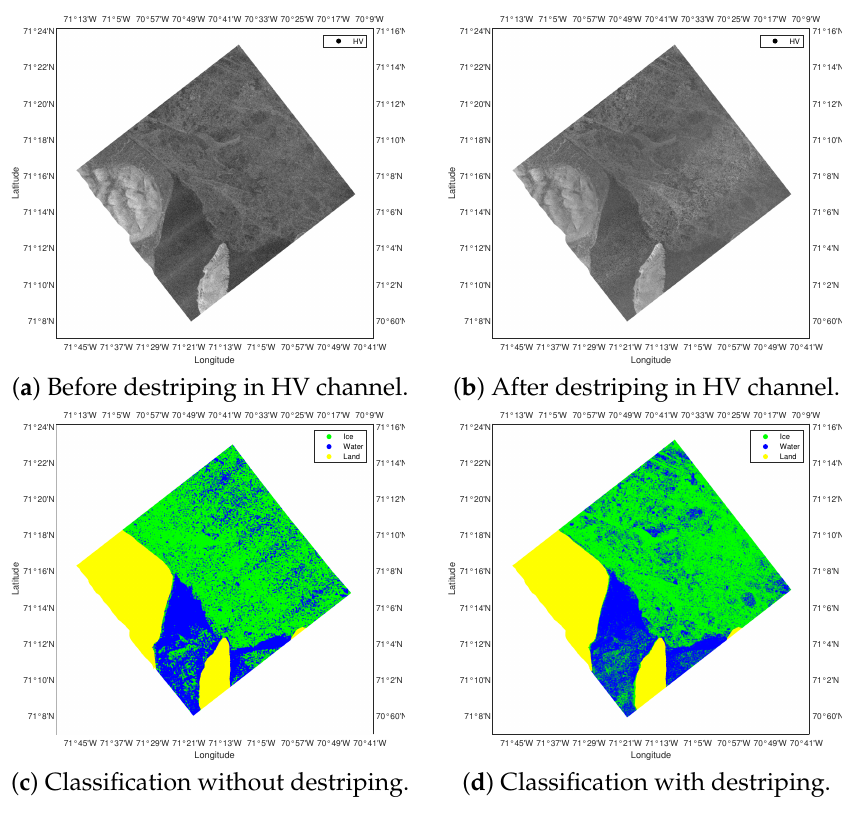
( c ) Classification without destriping. ( d ) Classification with destriping. Figure 3. Destriping examples. Image acquired on 2 March 2021. Geocoding is implemented via range doppler terrain correction, which uses available orbit state vector information, the radar timing annotations, the slant-to-ground range conversion parameters in the metadata file with the reference Digital Elevation Model (DEM) data to derive the precise geolocation information [51]. The most commonly used DEM is SRTM, which only provides high-precision elevation data below 60 ◦ N. The study area is over 60 ◦ N, so Copernicus DEM GLO-30 was selected for geocoding because it provides global elevation data with a 30 m resolution. To realize automatic labeling as described in the last section, Lambert Conformal Conic 2SP was used for map projection, of which the projection parameters are consistent with the digital sea ice chart. Finally, land regions were masked out according to the DEM in order to avoid false